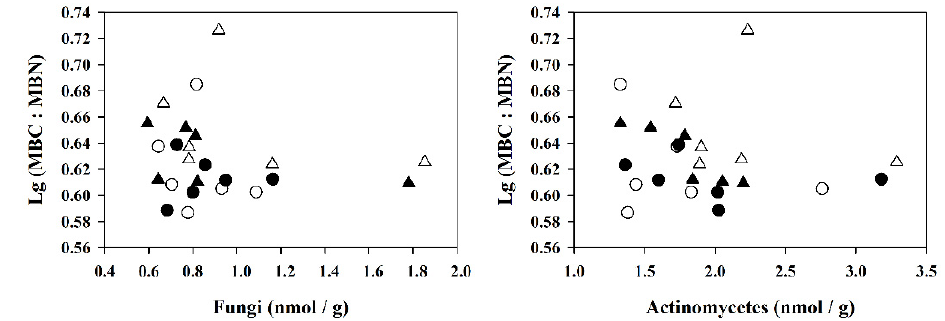
Figure 3. Relationships between MBC:MBN ratio and soil microbial groups in L. principis-rupprechtii plantations with different density.